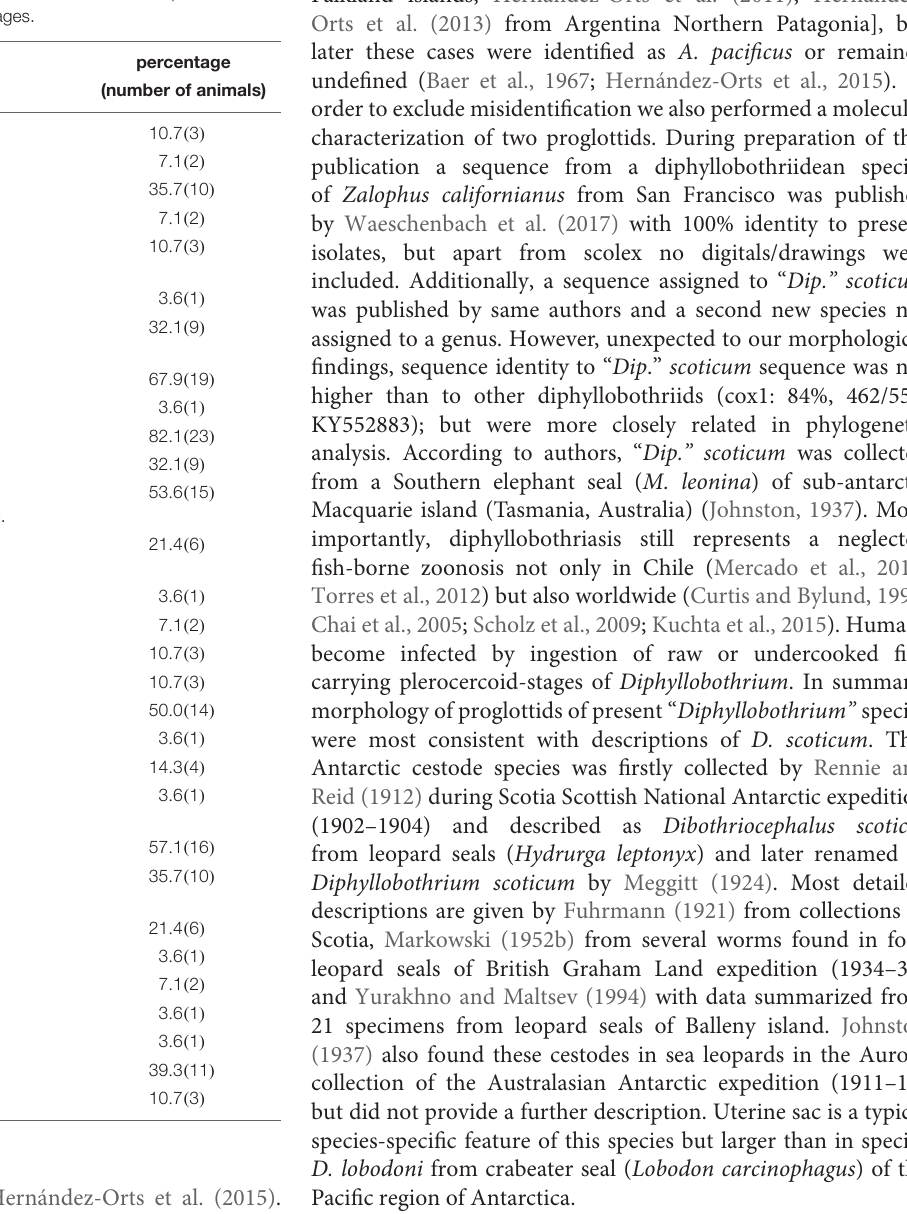
TABLE 3 | Bacterial species isolated from South American sea lion ( Otaria flavescens ) samples with respective percentages. Isolate or group percentage Achromobacter